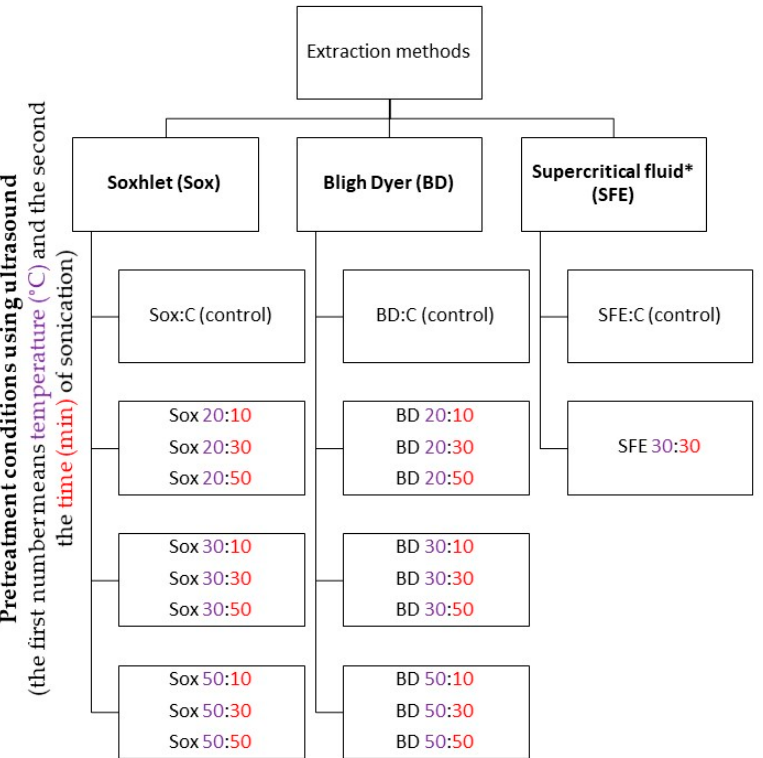
Figure 1. Experimental parameters for obtaining grape seed oil using di ff erent treatment conditions (time and temperature) with ultrasound and control sample (CC) obtained by di ff erent methods (BD: Bligh and Dyer; Sox: Soxhlet, and supercritical fluid extraction (SFE)). Pretreatment conditions using ultrasound: the first number means temperature ( ◦ C) (purple) and the second number means the time (min) (red) of sonication. BD: Bligh and Dyer; Sox: Soxhlet; SFE: Extraction with supercritical fluid; C (control)—corresponding the control samples. * SFE performed after defining the best pretreatment ultrasound condition for conventional techniques (BD and Sox).